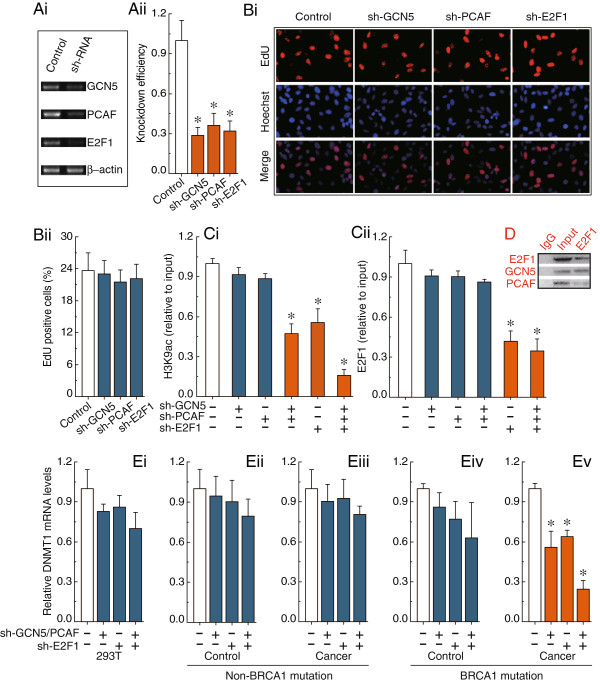
H3K9ac and E2F1-mediated transcriptional regulation of DNMT1. Ai, RT-PCR showing GCN5, PCAF and E2F1 levels before and after knockdown by shRNAs, and normalized to β-actin expression. Aii, the results from three independent experiments are represented as mean ± SD. Bi, EdU labeling showing proliferation of GCN5, PCAF and E2F1-silenced and control cells. Blue, Hoechst 33342 labeling of cell nuclei; Red, EdU labeling of nuclei of proliferative cells. Bii, the EdU incorporation rate was expressed as the ratio of EdU positive cells to total Hoechst33342 positive cells. Ci and Cii, analysis of histone modification H3K9ac and transcription factor E2F1 enrichment around the E2F1 motif within the CpG islands after the deletion of GCN5, PCAF or E2F1. D, The interaction of E2F1 and GCN5 or PCAF were examined by the immunoprecipitation of cell extracts with an antibody to E2F1, and co-immunoprecipitation of E2F1, GCN5 and PCAF by western blot analysis. Results of Figure
5A-D were obtained in BRCA1-mutated breast cancer cells, and the same results were also obtained in 293 T cells and non-BRCA1 mutated breast cancer cells. Ei-Ev, the DNMT1 expression levels after deletion of H3K9ac and E2F1 around the E2F1 motif in 293 T cells, and 15 primary non-mutated and BRCA1-mutated breast cancer and their normal breast cells. Each experiment was repeated four times for 293 T cells and primary breast cells of each patient. Bar graphs show mean ± SD. * P < 0.05 vs. Control.